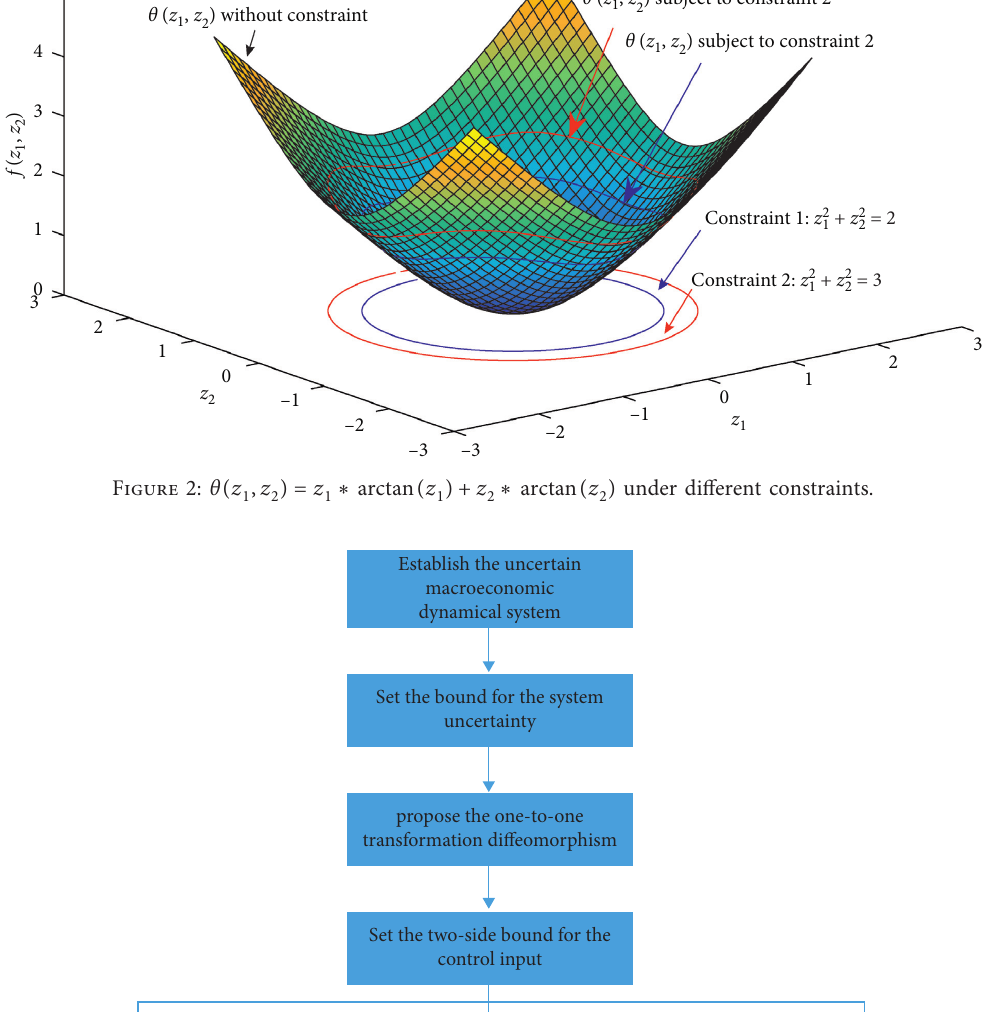
Figure 3: Control design